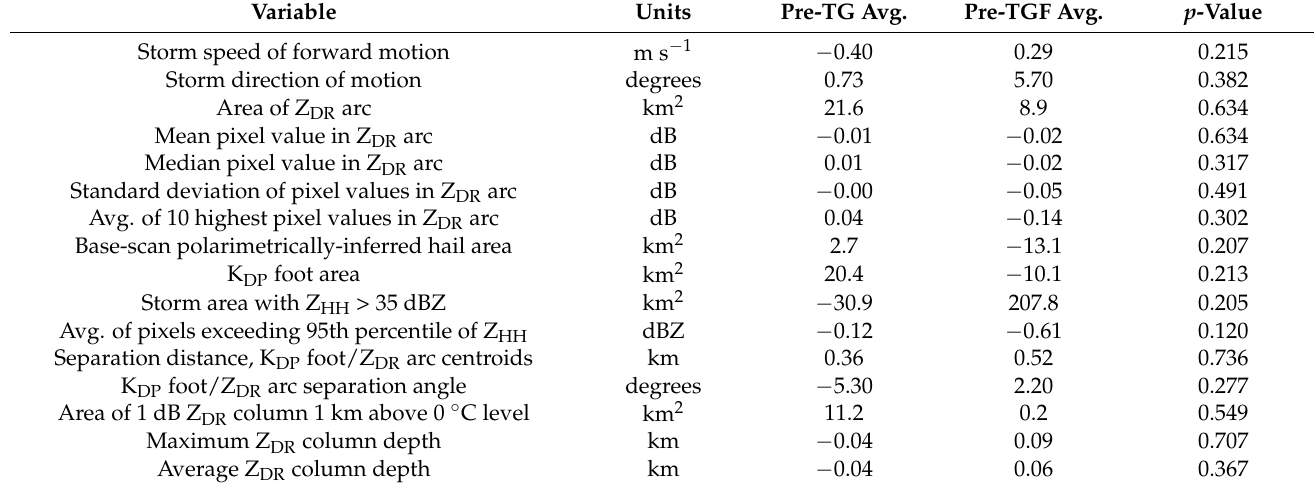
Table 5. Average change of each radar metric examined for pre-tornadogenesis (Pre-TG) and pre-TGF storms, and WMW p -value comparing these two populations. Change is defined as the average metric value 0–15 min prior to tornadogenesis or TGF minus the average metric value 15–30 min